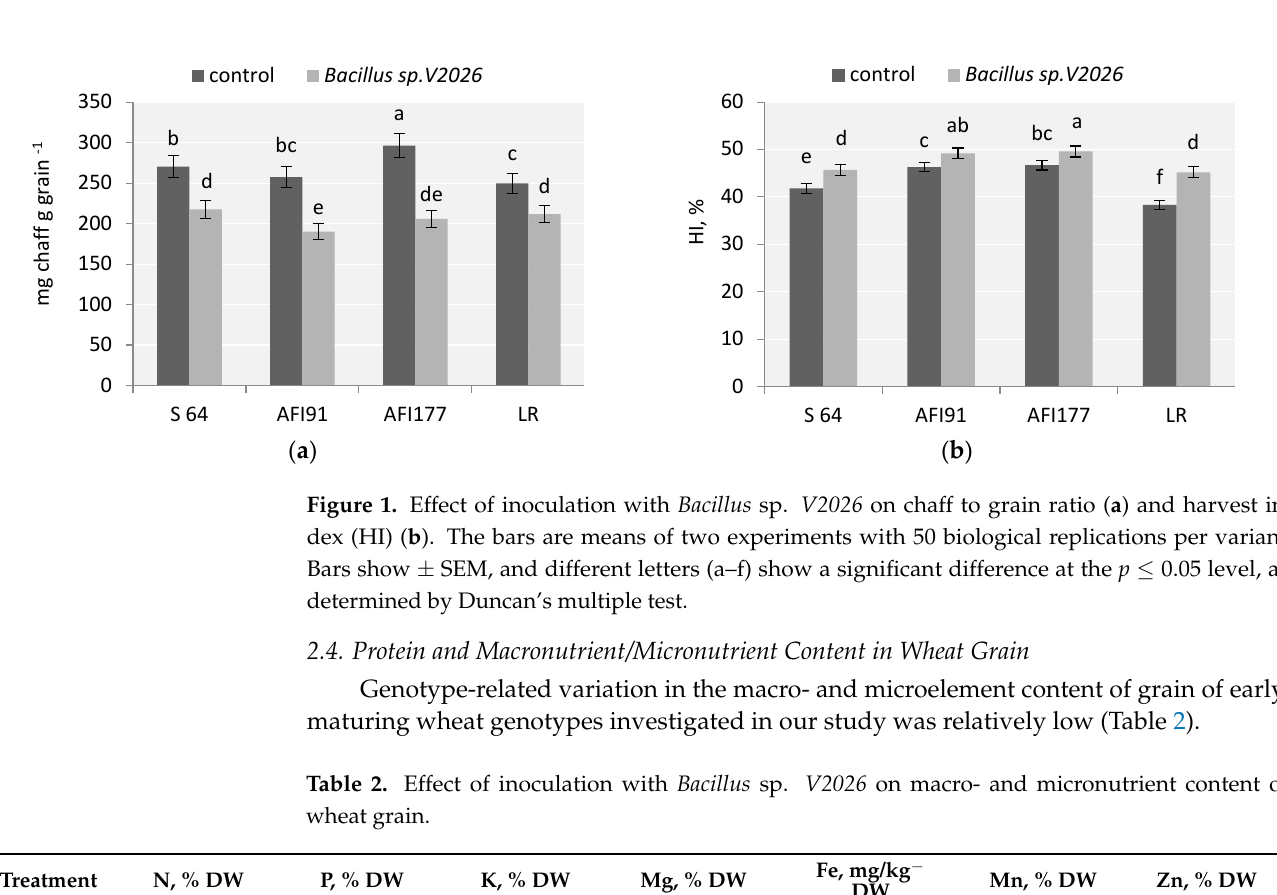
Table 2. Effect of inoculation with Bacillus sp. V2026 on macro- and micronutrient content of wheat grain.